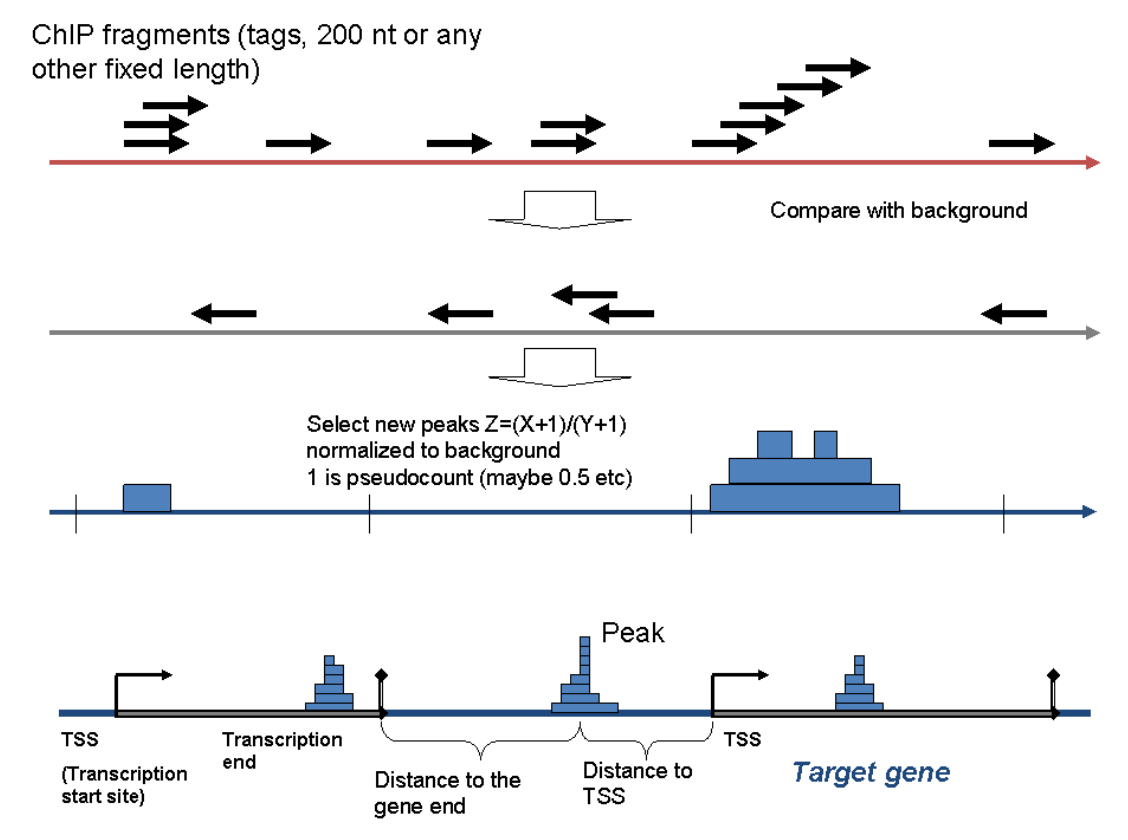
Figure 3: (top panels): Construction of binding profiles (piled DNA fragments) on chromosome coordinates and peak selection. (bottom): Peak location analysis. Selection of closest (nearest) gene for every cluster either to 5’ or to